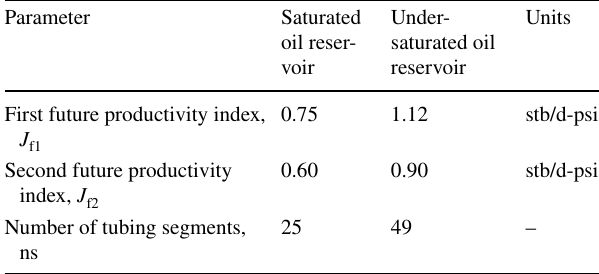
Table 2 Results from exercise (Guo et al. 2007,